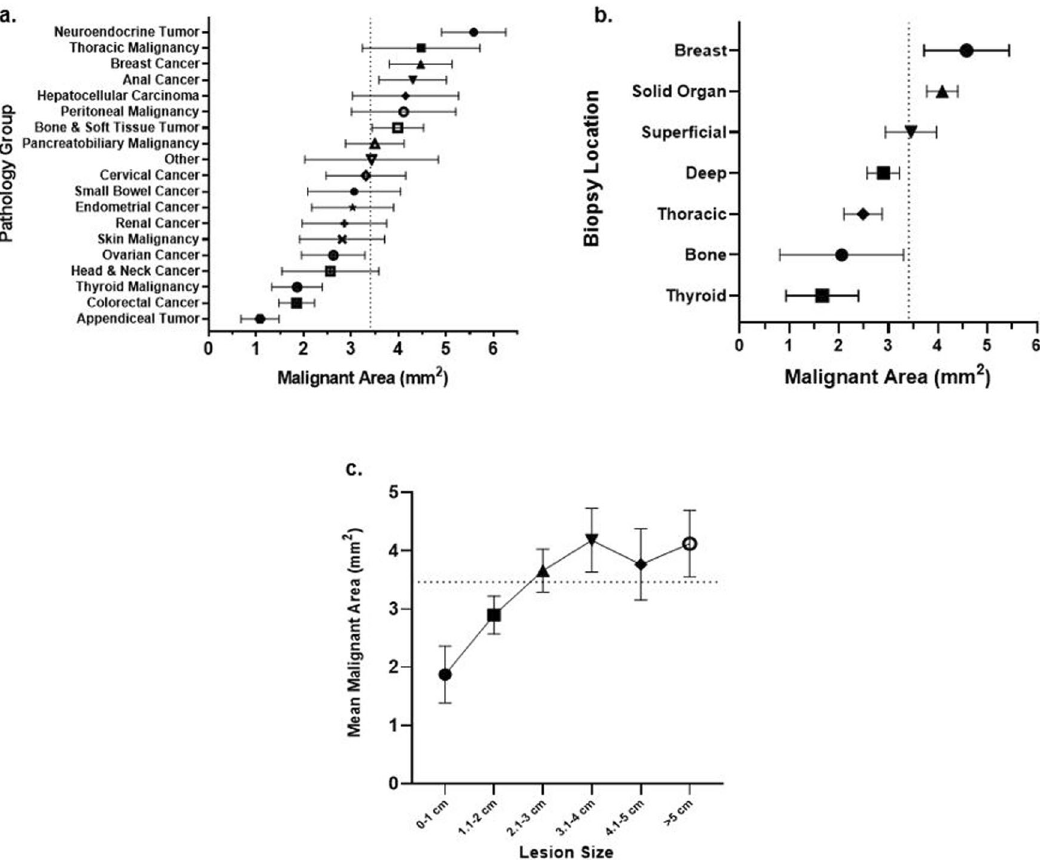
Fig. 3 Malignant area by tumor pathology, biopsy location, and lesion size. a The average malignant area per core for each biopsy strati fi ed by pathology group is displayed above along with 95% con fi dence interval estimates. The dotted line represents the average malignant area per core for all biopsies. b The average malignant area per core for each biopsy strati fi ed by location is displayed above along with 95% con fi dence interval estimates. The dotted line represents the average malignant area per core for all biopsies. Note: The majority of breast biopsies were performed using 14-gauge needles and the majority of thyroid and thoracic biopsies were performed using 20-gauge needles. c The average malignant area per core for each biopsy strati fi ed by lesion size is displayed above along with 95% con fi dence interval estimates. The dotted line represents the average malignant area per core for all biopsies where lesion size was